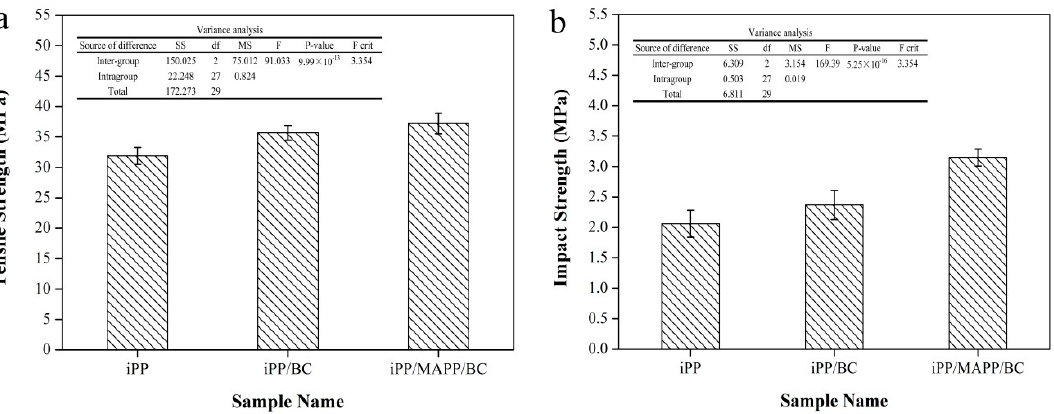
Figure 4. Mechanical properties of the iPP/BC hamburger composite: ( a ) tensile strength; ( b ) impact strength).